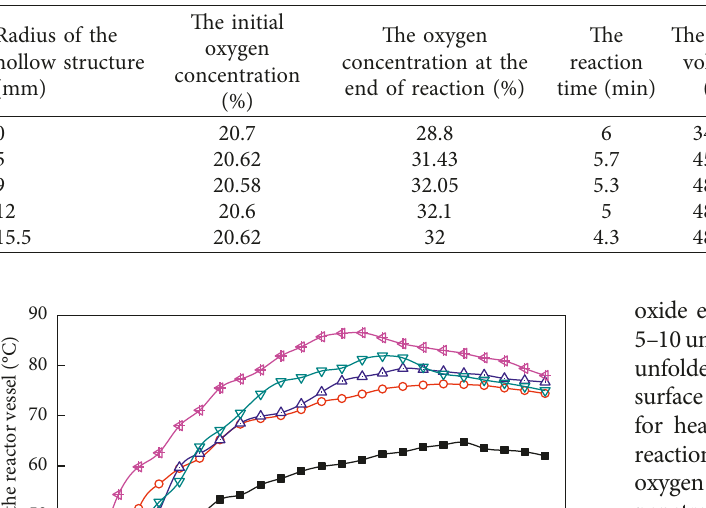
Figure 8: Relationship between oxygen concentration and reaction Table 1: Oxygen concentration, oxygen generation, and the average OGR.